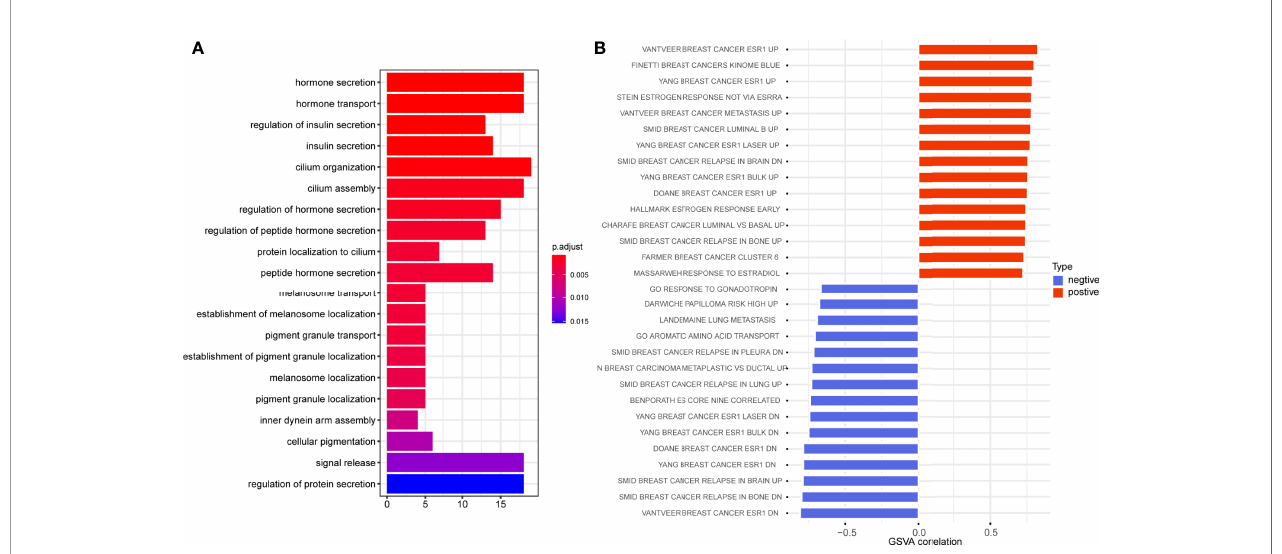
FIGURE 5 | GO enrichment analysis (A) and GSVA analysis (B) of C5AR2 related to biological processes in breast cancer.